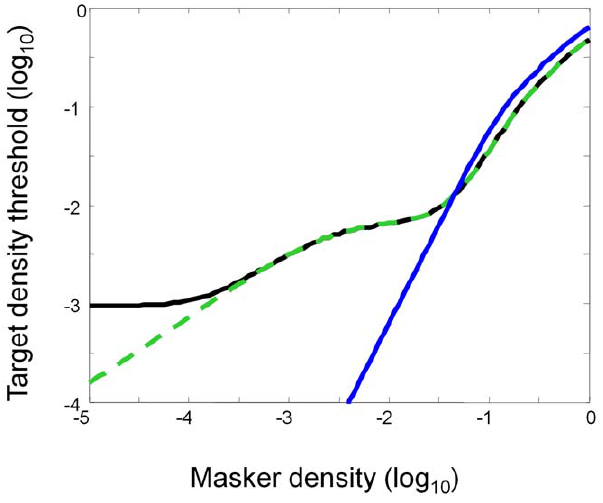
Figure 6. Examples of the model parametrization. The black curve has all three model components in the denominators, with parameters chosen to for a strong double-corner effect. Green curve: removing the internal noise reduces the threshold at low masker density. Blue curve: removing the divisive inhibition limits the masking effect at high masker density. (Removing the external noise results in a horizontal line, since it is the parameter of the x axis.)